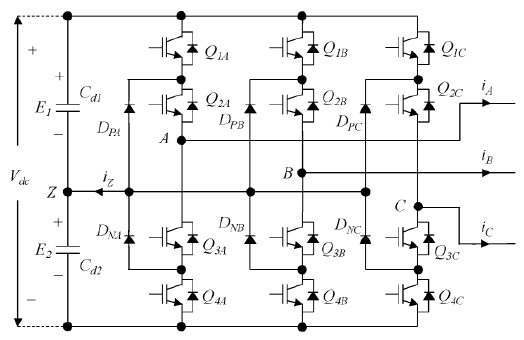
Figure 1. Circuit of a typical NPC three-level inverter. Table 1. Switching mode of the conventional switching method.